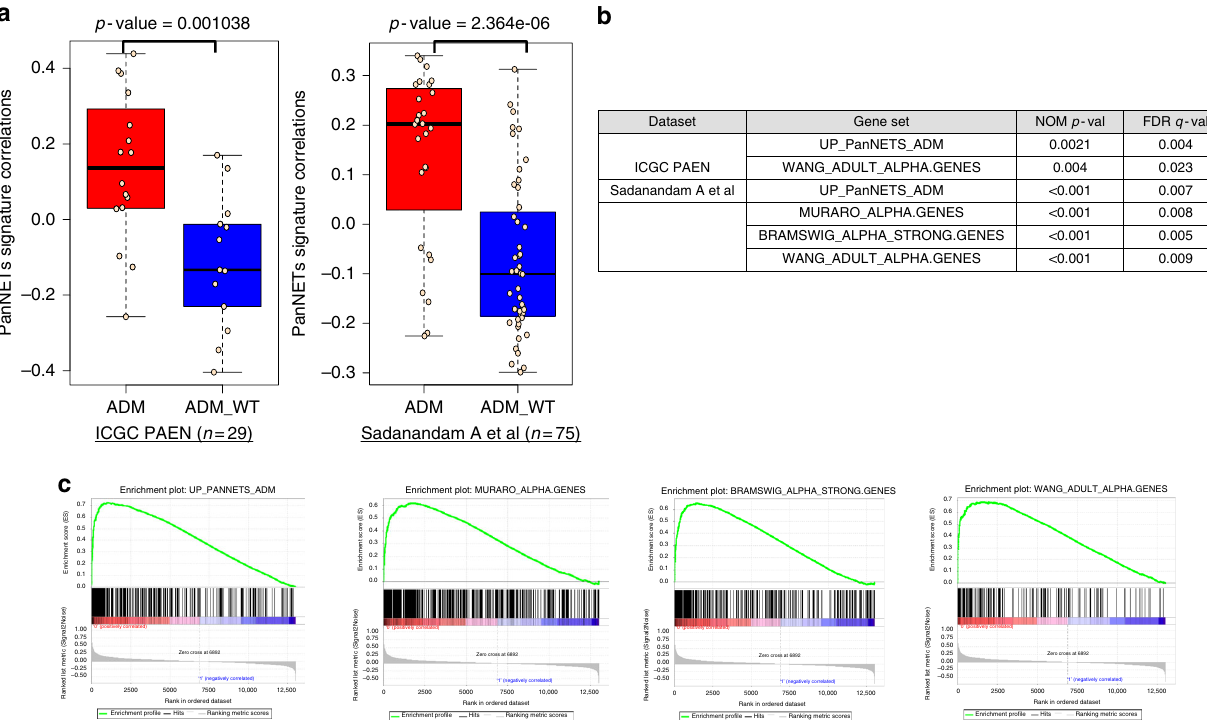
Fig. 5 Validation of A-D-M mutant PanNET and alpha cell signatures. a Pearson correlation boxplot for two independent PanNET datasets show signi fi cant positive and negative correlations of A-D-M mutant and WT PanNETs with our A-D-M mutant PanNETs signature respectively (red represent A-D-M mutant and blue represent A-D-M WT with Wilcox p-value; center line is median, bounds of box are fi rst and third quartile, and whiskers are min and max). b GSEA analysis shows A-D-M mutant PanNETs from ICGC PAEN 6 and Sadanandam et al. 13 are enriched for A-D-M mutant and alpha cell gene signatures. c GSEA enrichment plot for signi fi cant gene set for A-D-M mutant and alpha cell gene signatures from Sadanandam et al. dataset